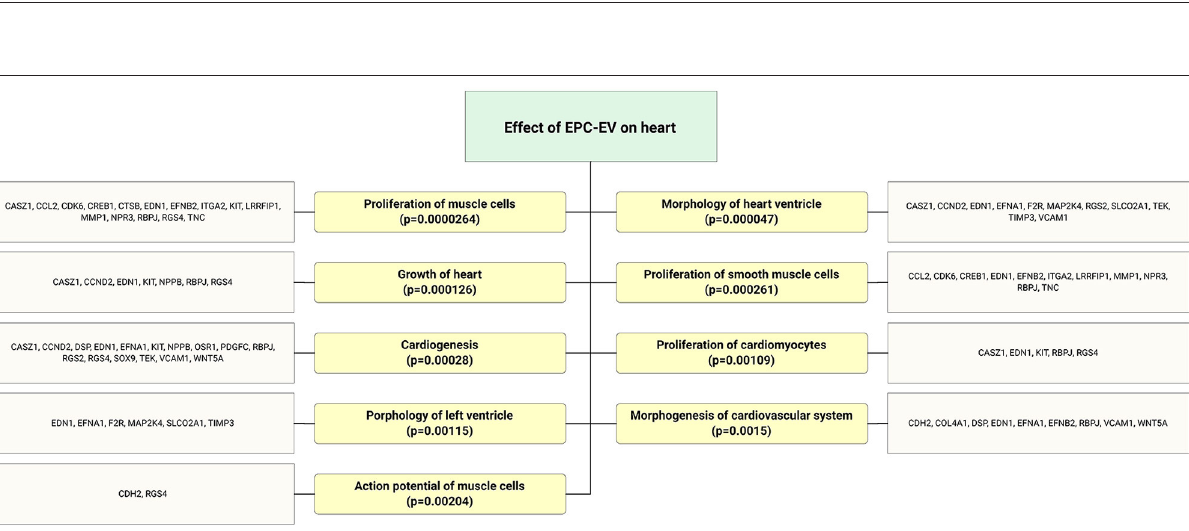
FIGURE 5 | Flow chart depicts highly expressed ECFC-EC-derived miRs biological targets that were predicted in silico . The significantly enriched functional annotation was associated with heart tissue repair. This miR sequence data was generated from PMID: 28631889. MicroRNA target genes were predicted using IPA with information from TargetScan, miRecords, and TarBase